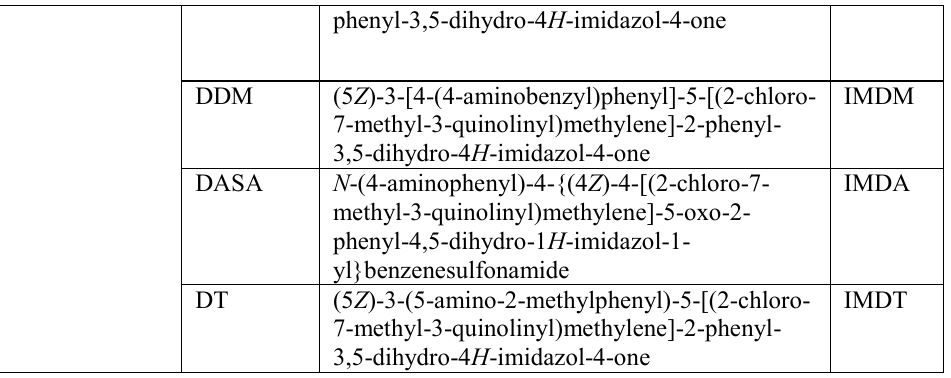
Table 1. Elemental analysis of imidazoles based on 2-chloro-7-methyl-3-formylquinoline. Elemental Analysis Imidazole Molecular MW %H %N code Formula g/mol Calc. Found Calc. Found Calc. Found